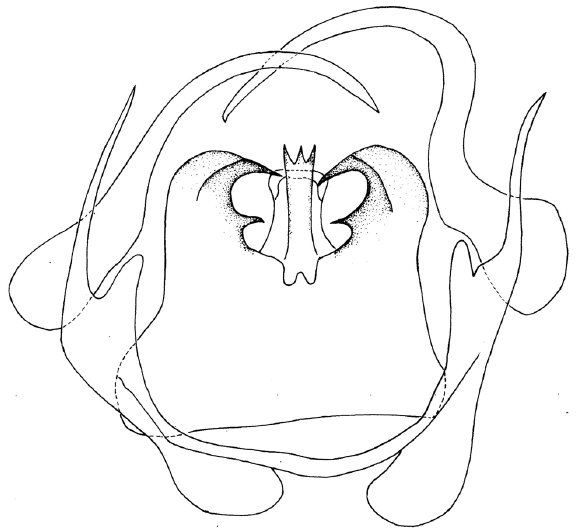
Figures 23. Dilar pallidus Nakahara, male genitalia, ventral view. Reproduced from Nakahara